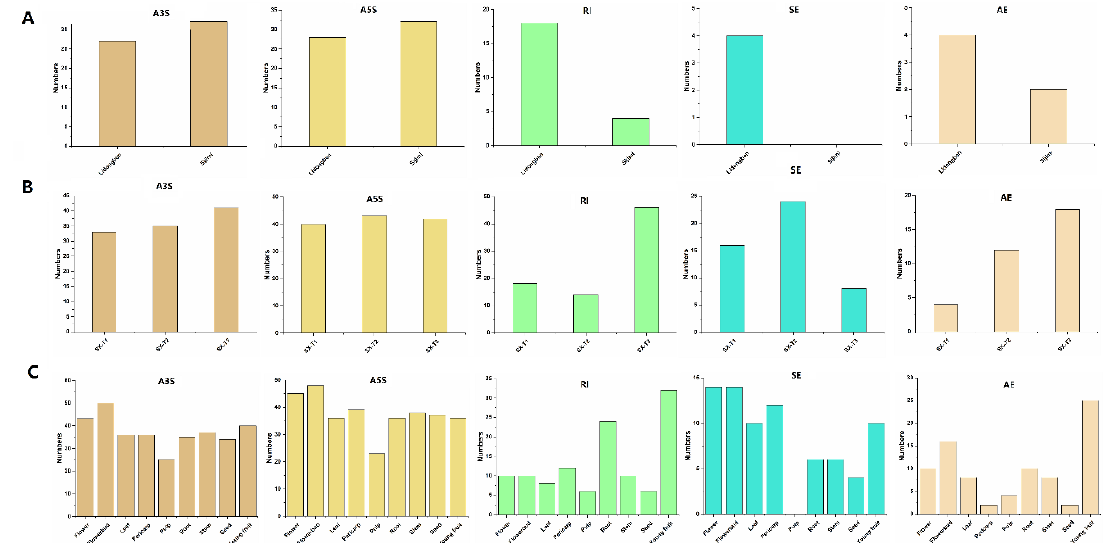
Figure 6. The numbers of different types of alternative splicing (AS) events of the DlST genes. ( A ) The AS events of the DlST genes identified in ‘Lidongben’ and ‘Sijimi’. ( B ) The AS events of the DlST genes identified in different floral bud development stages in ‘Shixia’. SX-T1 represent stage before the emergence of floral primordia, SX-T2 represent stage of the appearance of red dot, and SX-T3 represent stage of the appearance of the first inflorescence apical buds. ( C ) The AS events of the DlST genes identified in nine tissues of ‘Sijimi’ clutivar.